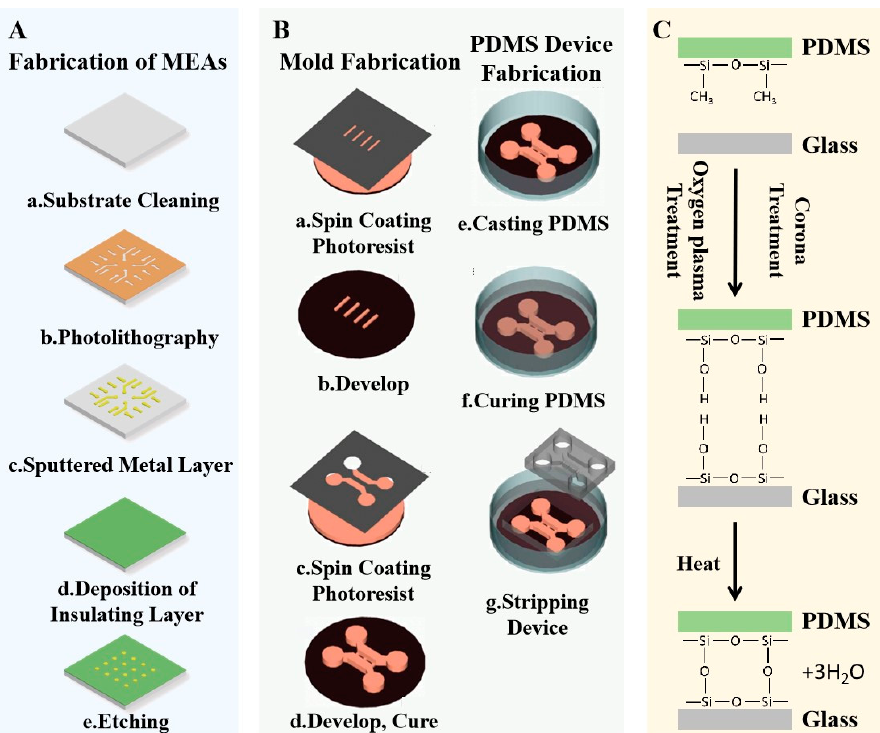
Figure 5. Fabrication process of a neural chip platform integrating microfluidics and MEAs. ( A ) Fabrication process of planar in vitro MEAs, including substrate cleaning (a), photolithography (b), sputtering a metal layer (c), deposition of an insulating layer (d) and etching an open window [31]. Reproduced with permission from Xu, Biosensor; published by MDPI, 2022. ( B ) Fabrication process of microfluidic devices based on SU-8 mold, including mold fabrication (a–d) and PDMS device fabrication (e–g) [116]. Reproduced with permission from Park, Nature Protocols; published by Nature, 2006. ( C ) Surface activation-based bonding